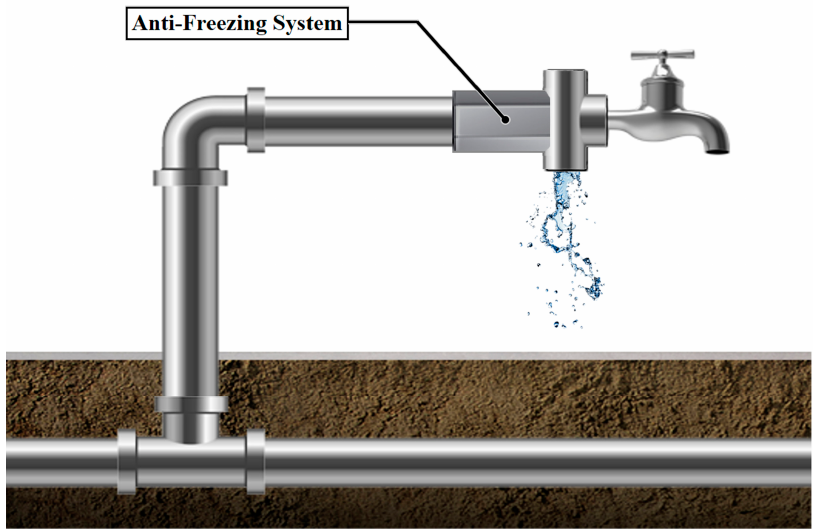
Figure 2. FRSS applied anti-freezing valves using the SMA coil spring.